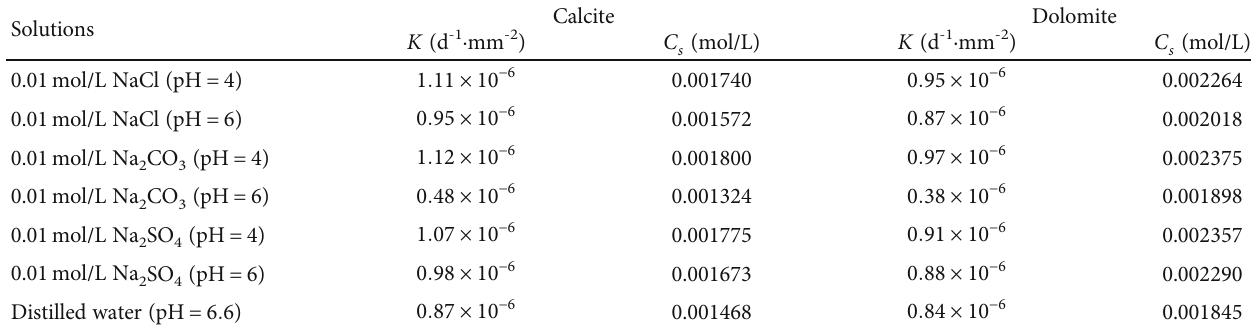
Table 11: Values of K and C s of calcite and dolomite in static solutions.